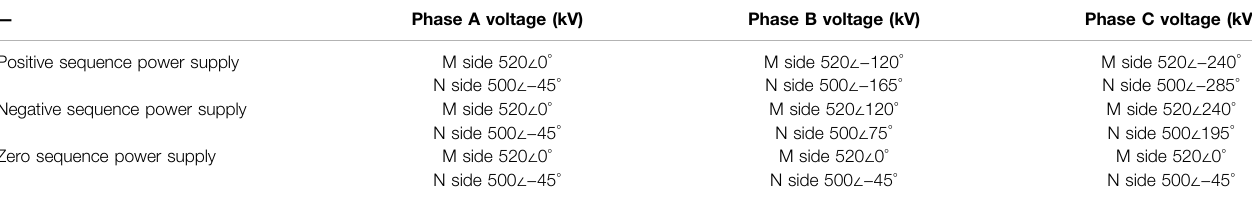
TABLE 3 | M side and N side power supply parameters.